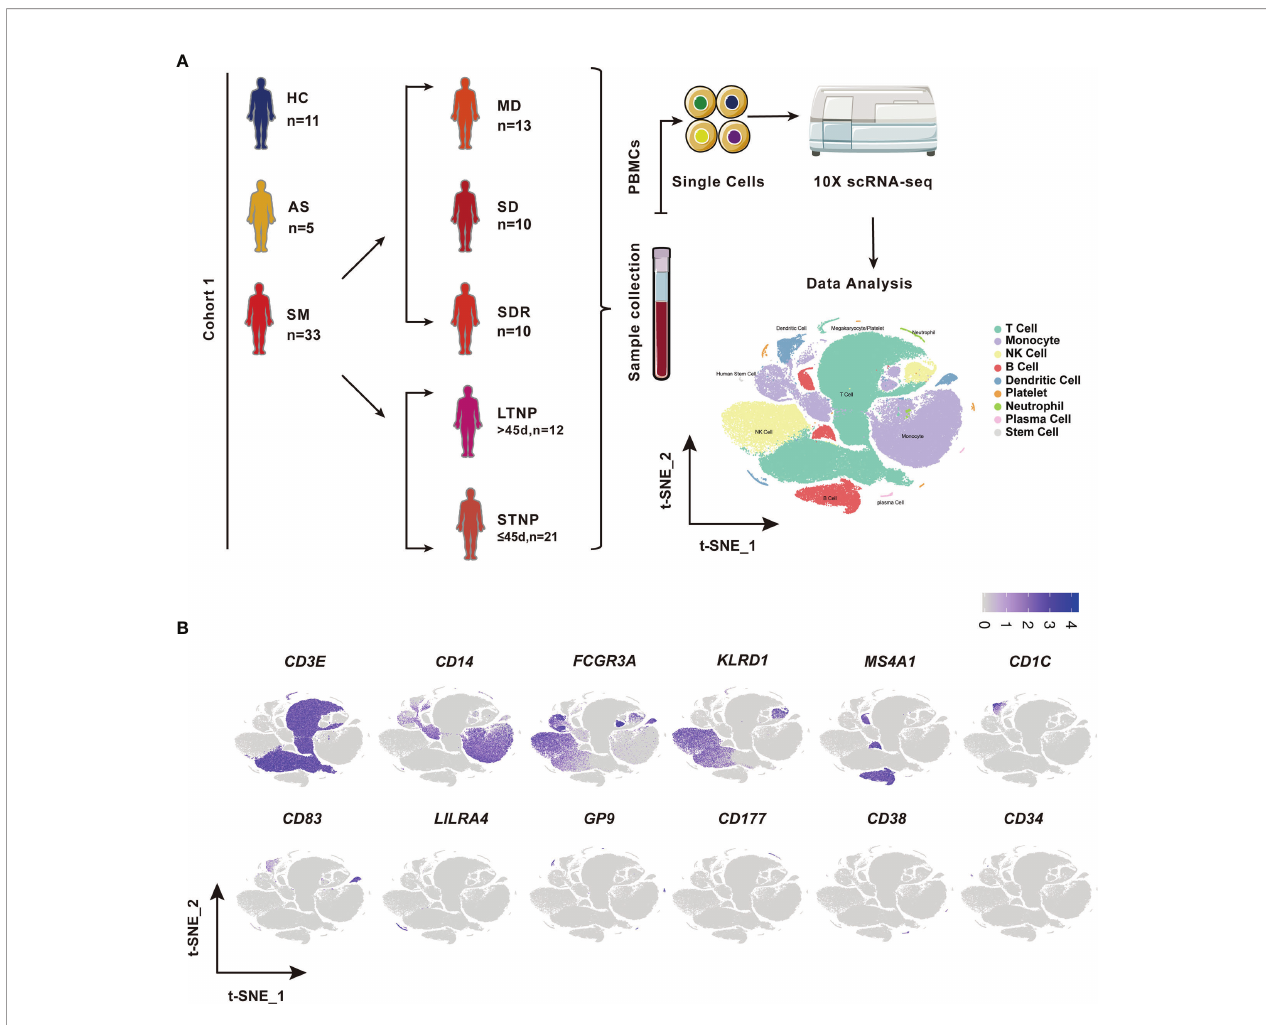
FIGURE 1 | Identi fi cation of nine cell types in the peripheral blood mononuclear cells (PBMCs). (A) A schematic diagram of the study design for single-cell RNA sequencing (scRNA-seq). Peripheral blood mononuclear cells (PBMCs) were collected from eleven healthy controls (HC) and 39 SARS-CoV-2 infected